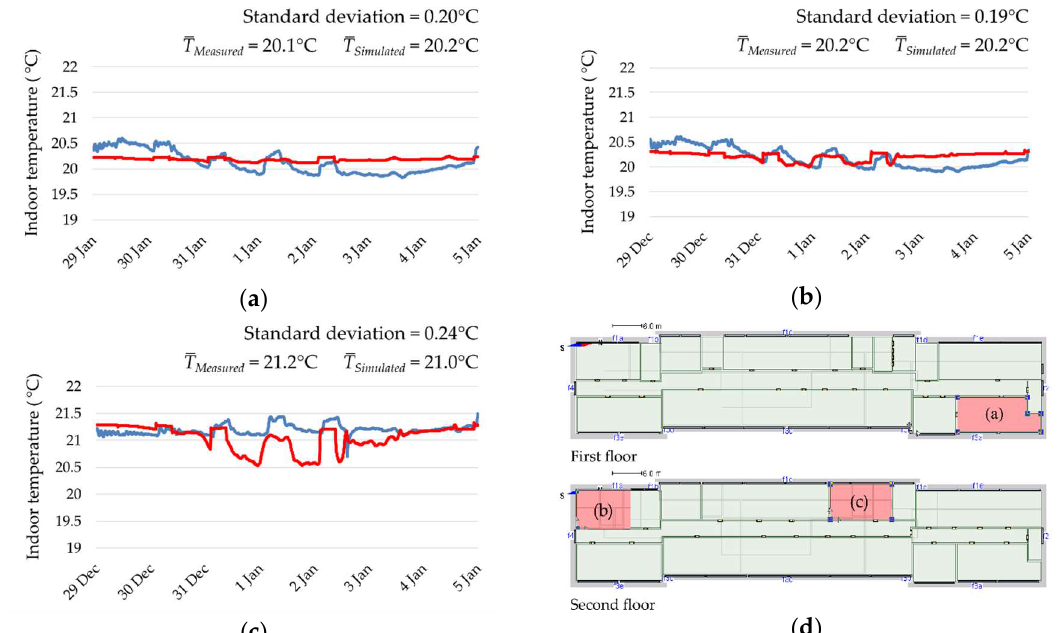
Figure 10. Measured (blue line) and simulated (red line) indoor temperatures in the three validation rooms, staff lunchroom ( a ), teachers’ office ( b ), and classroom ( c ) during the unoccupied validation period and location of the validation zones at building floorplans ( d ).